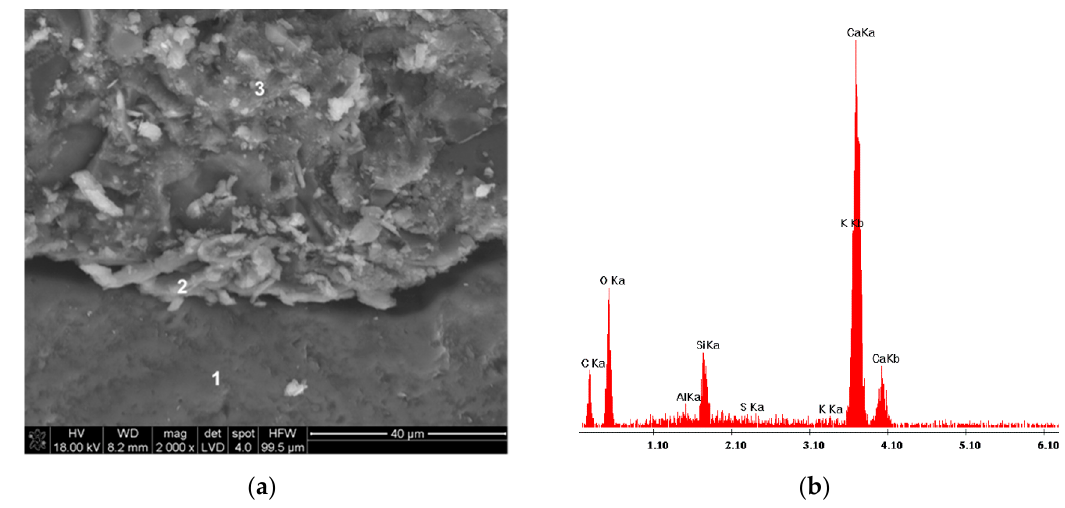
Figure 13. Microstructure of interfacial transition zone: ( a ) Concrete without basalt dust after 28 days of hydration: point 1—aggregate grain, point 2—portlandite, point 3–C–S–H phase; ( b ) Analysis in the micro-area defined in point 2.